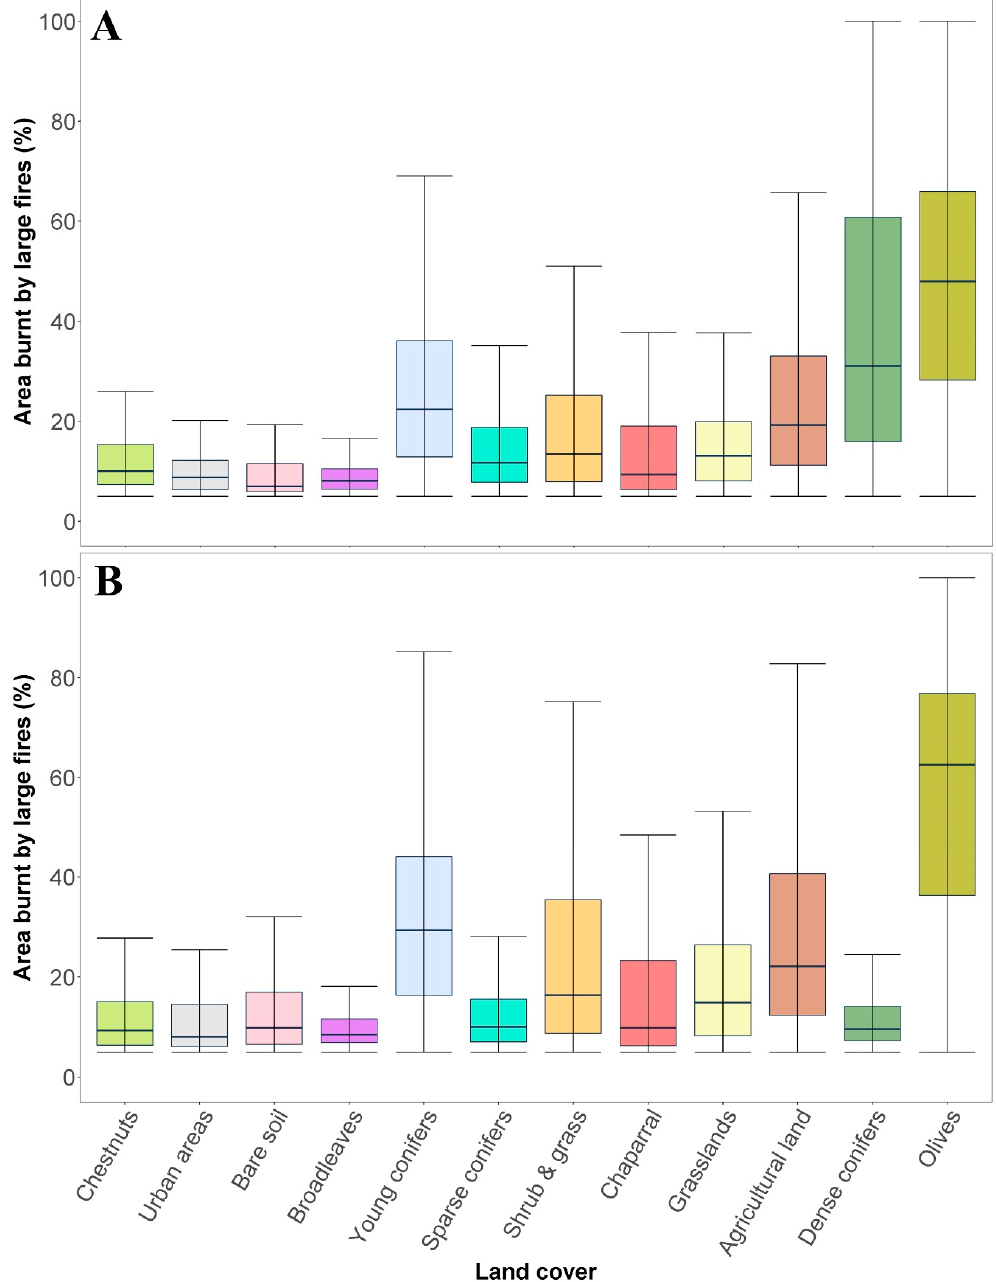
Figure A5. Statistical distributions for the percentage of burned area of each land cover type from the total area burned from each large simulated fire ( > 50 ha), obtained after 10,000 simulated fires with the minimum travel time algorithm for: ( A ) baseline conditions; ( B ) after the application of fuel treatments. The number of large simulated fires for ( A ) was 8470, while for ( B ) it was 5510. Values less than 5% from the total burned area of each land fire were not included in the statistical distributions (e.g., when a large fire of a total burnt area of 100 ha burned less than 5 ha in broadleaves).